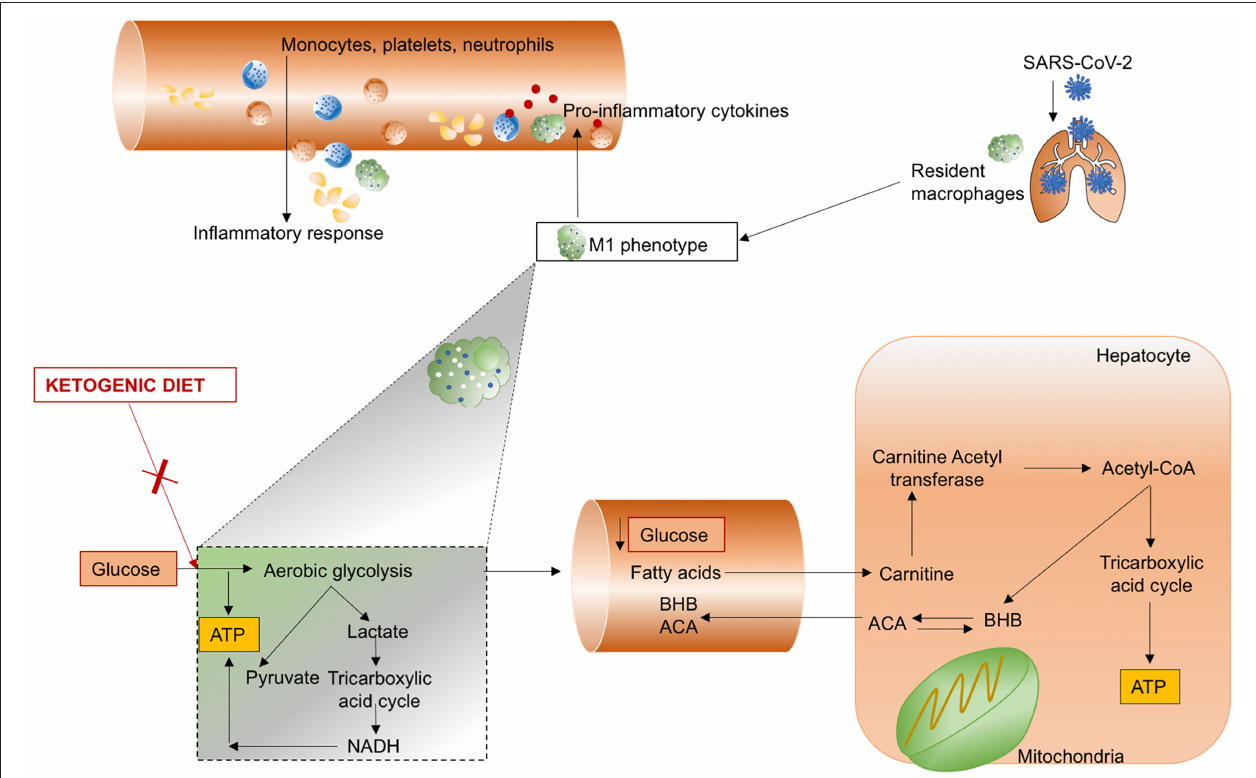
FIGURE 5 | Ketogenic diet. SARS-CoV-2 infects the lung and induces hyperinflammation with recall of monocytes, platelets, and neutrophils by macrophages polarized to the M1 phenotype. A ketogenic diet is able to reduce the synthesis of adenosine triphosphate (ATP) from glucose by limiting aerobic glycolysis, usually implicated in the production of lactate and pyruvate, and activation of the tricarboxylic acid cycle, culminating in increased nicotinamide adenine dinucleotide (NADH). Glucose concentration in the blood is reduced, thereby increasing the production of β -hydroxybutyrate (BHB) and acetoacetate (ACA) from hepatocyte